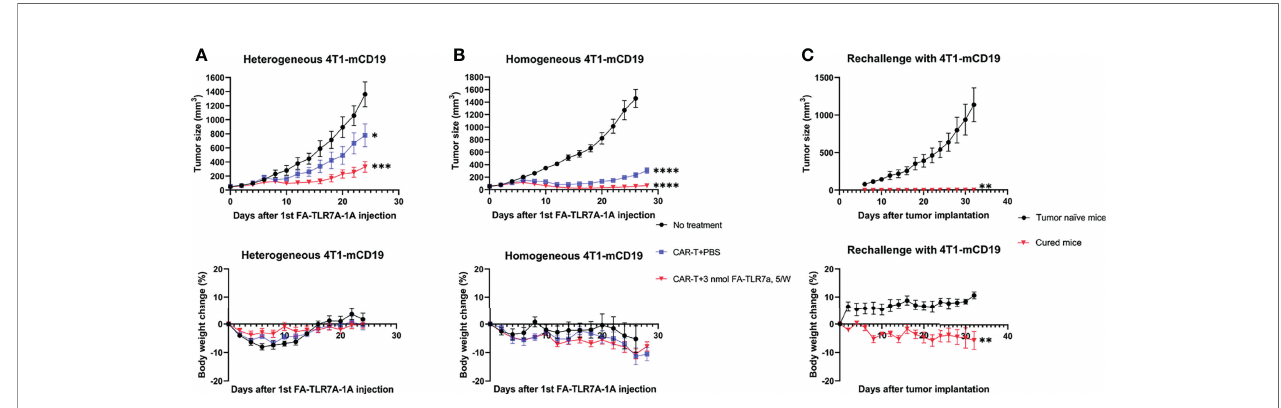
FIGURE 3 | Analysis of the ability of anti-CD19 CAR T cells to kill 4T1-mCD19 cells in vivo. (A) A “ heterogeneous ” preparation (not a single cell clone) of 4T1- mCD19 ” tumor cells was implanted into balb/c mice and allowed to form 50 mm 3 tumors prior to initiation of therapy either with saline (black line), anti-mCD19 CAR T cells alone (blue line), or anti-mCD19 CAR T cells plus FA-TLR7-1A (red line). Tumor size (upper panel) and total body weight (lower panel) were then monitored as a function of time. (B) The studies described in part A were repeated following isolation and expansion of a single cell clone of 4T1-mCD19 cells. (C) Mice from panel B that showed no sign of any residual cancer for 30 days after termination of the therapy were rechallenged with fresh 4T1-mCD19 cells and the growth of the resulting tumors was monitored (red line). Tumor naïve mice were similarly injected with the same number of 4T1-mCD19 cells and used as a control (black line). The above studies were conducted at least twice using cohorts of 5 to 9 mice per group each time. More speci fi cally, for the above studies involving heterogeneous 4T1- mCD19 tumors, the data derive from cohorts of 5 mice/group. For the above studies involving homogeneous 4T1-mCD19 tumors, the “ No treatment ” , “ CAR T +PBS ” , and “ CAR T+3n mol FA-TLR7-1A, 5W ” treatment groups contained 5, 6 and 9 mice/group, respectively. For rechallenge with 4T1-mCD19, n=4 for all the groups. Mean ± SEM. Statistical signi fi cance between multiple groups was determined using a 1-way ANOVA followed by a Tukey post hoc analysis. Statistical signi fi cance between two groups was determined using an unpaired two ‐ tailed t ‐ test (*P < 0.05, **P < 0.01, ***P < 0.001, ****P <